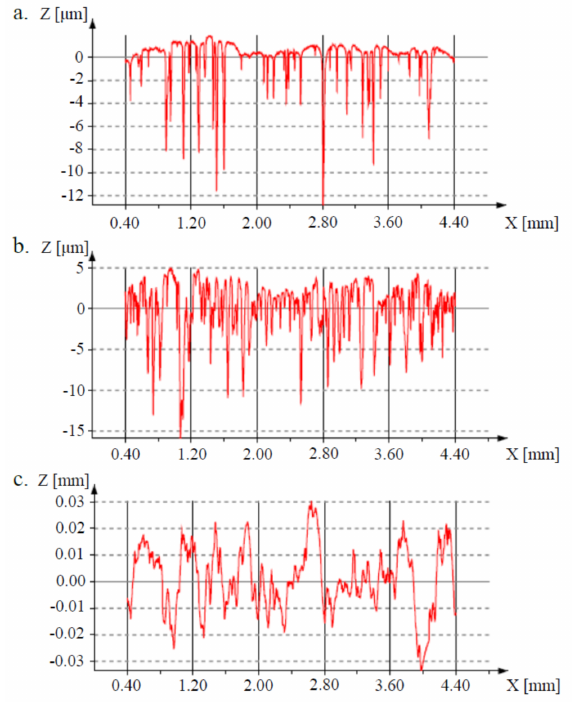
Figure 6. The surface roughness of the Ti31Mo before modification ( a ), after NaOH 60 ◦ C/24 h ( b ), and hydrothermal treatment ( c ).